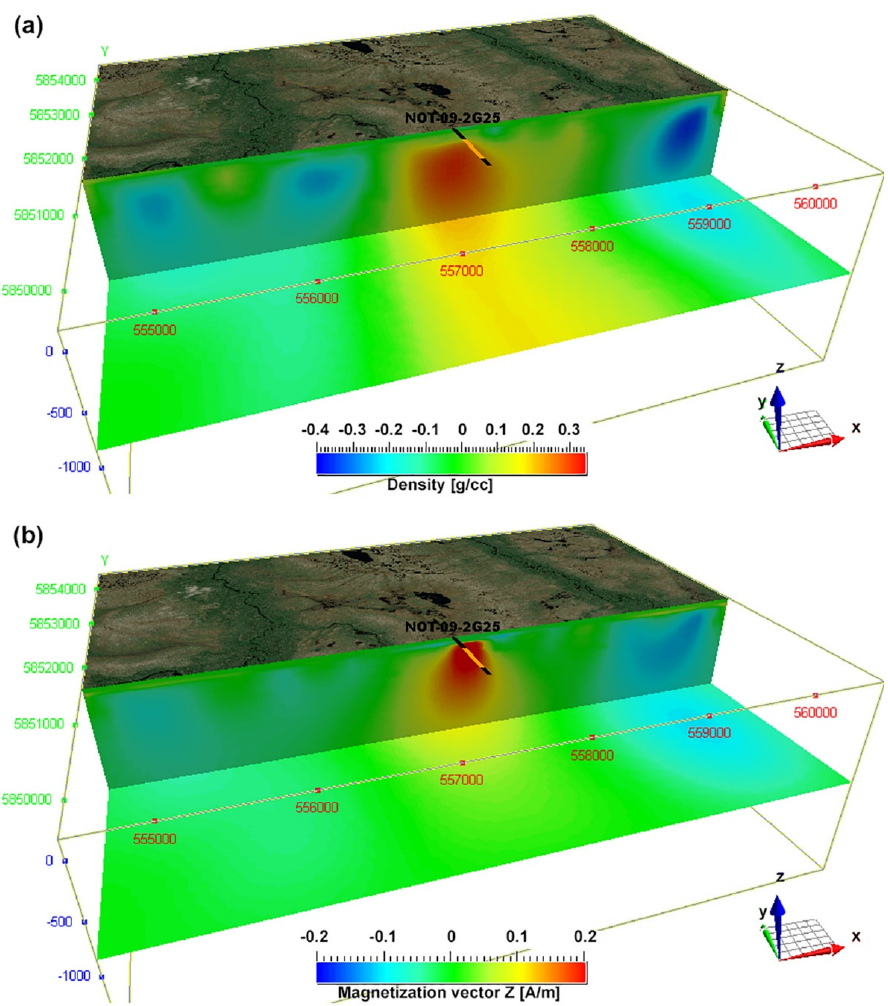
Figure 12. Top panel ( a ) shows the cut-off 3D image of the inverse density model. Bottom panel ( b ) presents the volume image of the vertical component of the magnetization vector. The black– yellow–black solid line shows the location of the borehole drilled in the survey area. The yellow color indicates the mineralization zone confirmed by drilling.